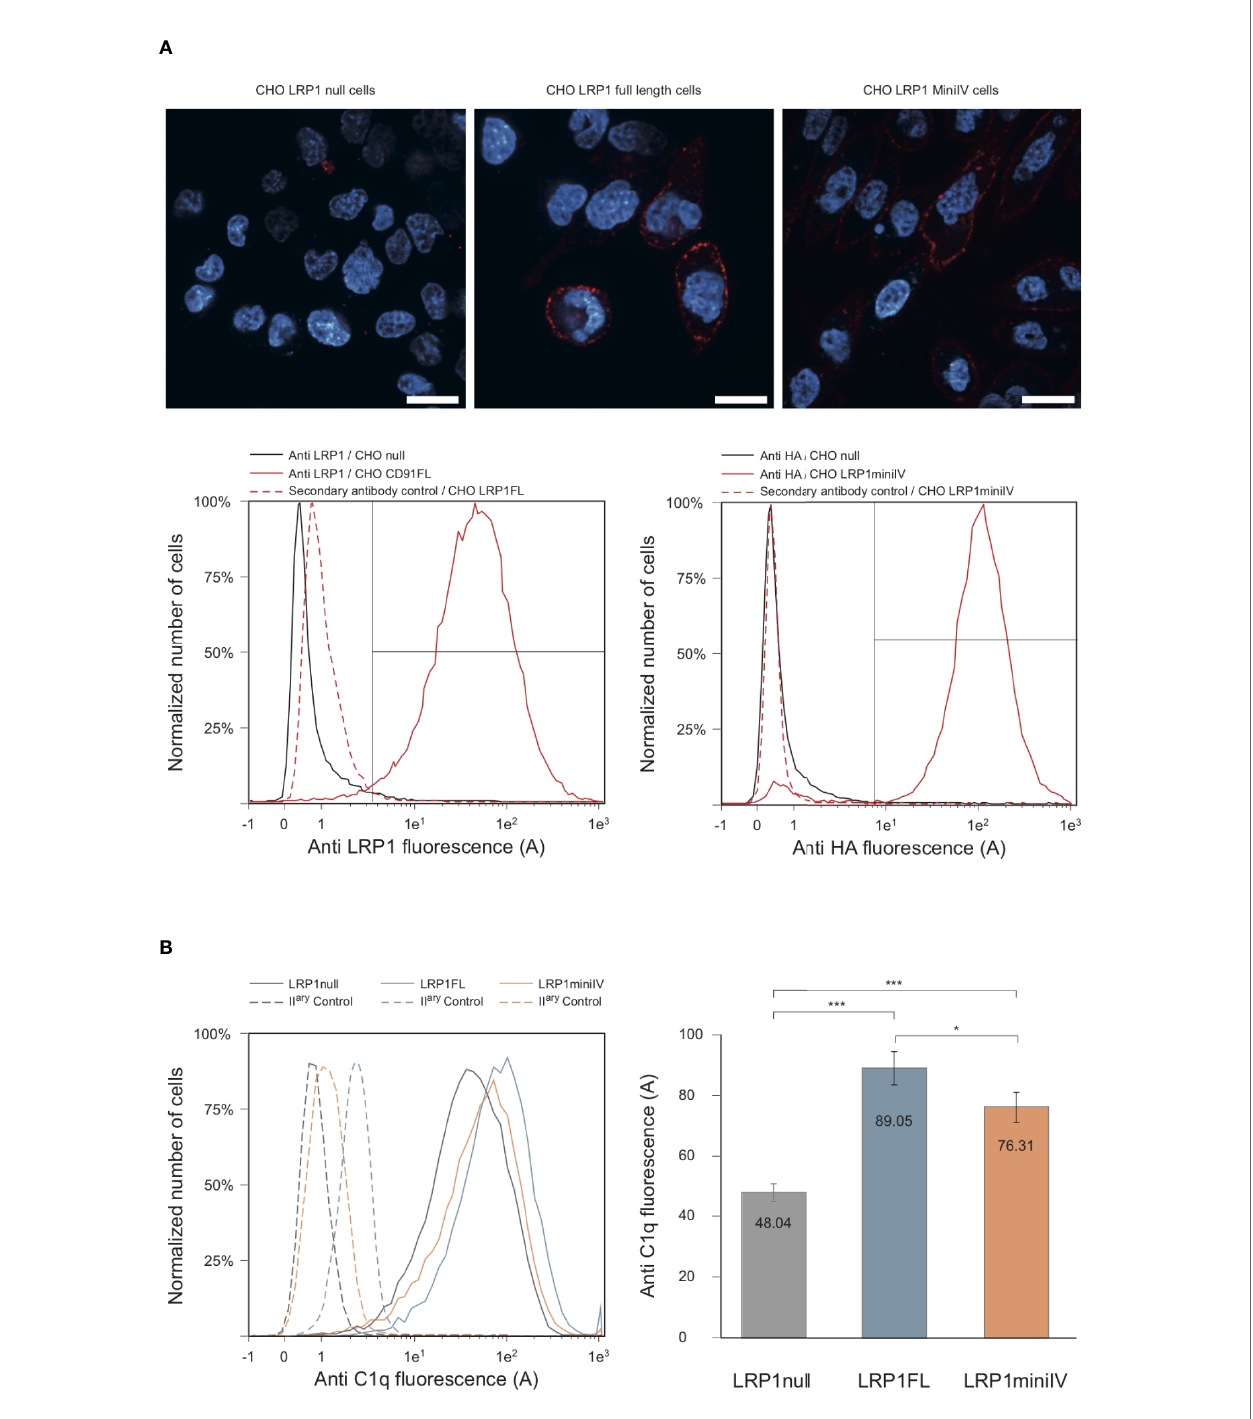
FIGURE 8 | C1q interacts with full-length LRP1 and mini IV at the surface of transfected CHO cells. (A) Antibody labeling of LRP1-null CHO cells and CHO cells transfected with full-length LRP1 or mini IV. Top panels, confocal sectioning of LRP1-null, full-length LRP1 and mini IV (red) DAPI counterstained (blue) adherent CHO cells (bars = 20 µm). Bottom panels, histogram overlays of the corresponding cell populations analyzed by fl ow cytometry. Left, control LRP1-null cells (black) and LRP1 full- length transfected CHO cells (red) labeled with anti LRP1 antibody. Right panel, control LRP1-null CHO cells (black) and mini IV transfected CHO cells (red) labeled with anti HA antibody. Red dotted histograms correspond to secondary antibodies controls. The region for positive cells is shown (brackets) and represents more than 95% of the total cell population. (B) Flow cytometric histograms of a typical C1q decoration experiment. Plain lines correspond to C1q binding to LRP1-null cells (grey), full-length LRP1 (blue) and mini IV (red) CHO cells. Dashed lines are the corresponding controls with only secondary antibody only. Right panel, mean C1q fl uorescence intensities (corrected from the controls) of six independent experiments. *** Student bilateral unpaired <1 × 10 − 4 . * Student bilateral unpaired >4 × 10 − 2